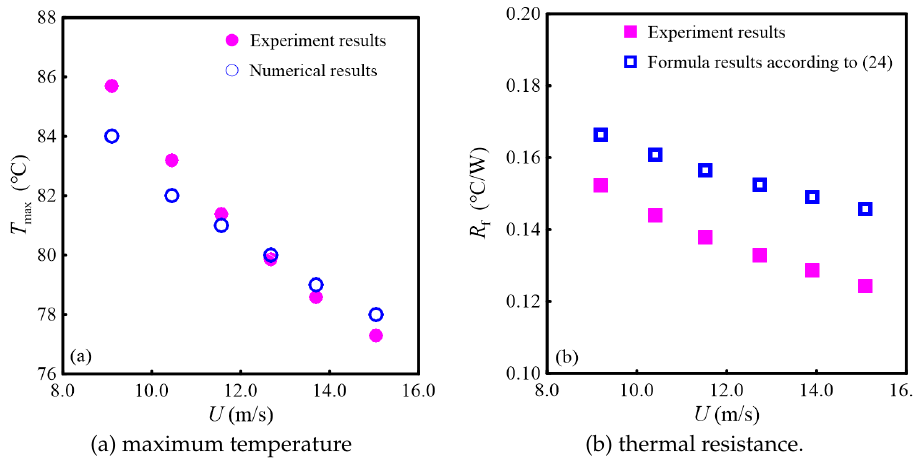
Fig. 8. Comparison of the maximum temperature and thermal resistance obtained via numerical simulations and